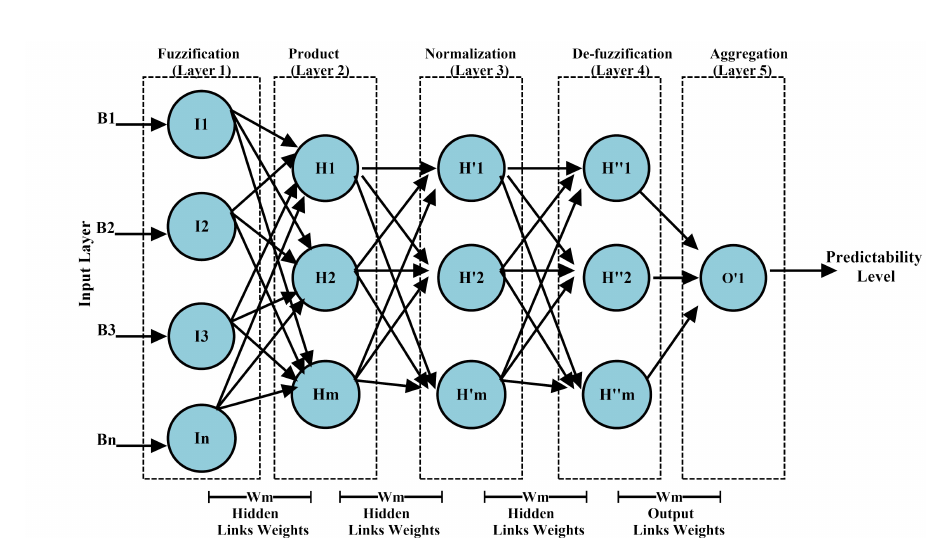
Figure 4. Adaptive Neuro-Fuzzy Inference System (ANFIS)